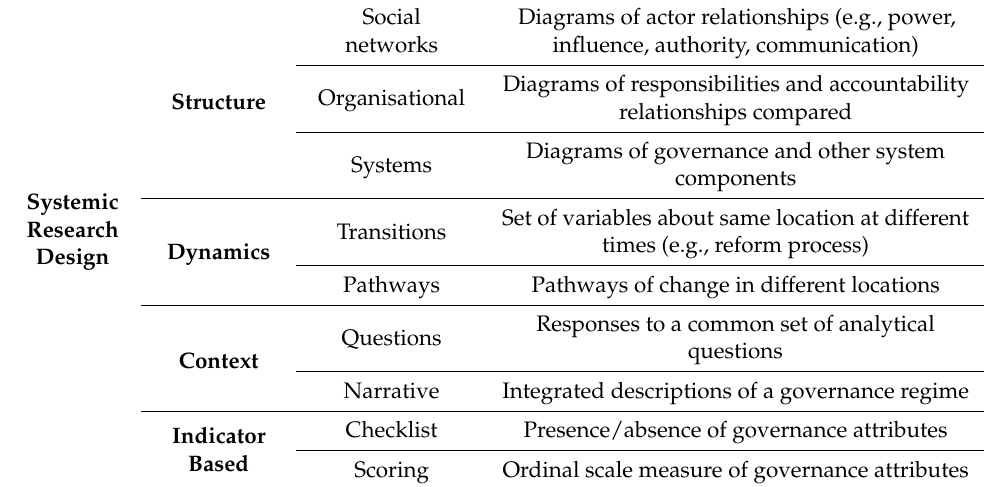
Table 3. Systemic Research Design—adapted from the typology of methods for comparative